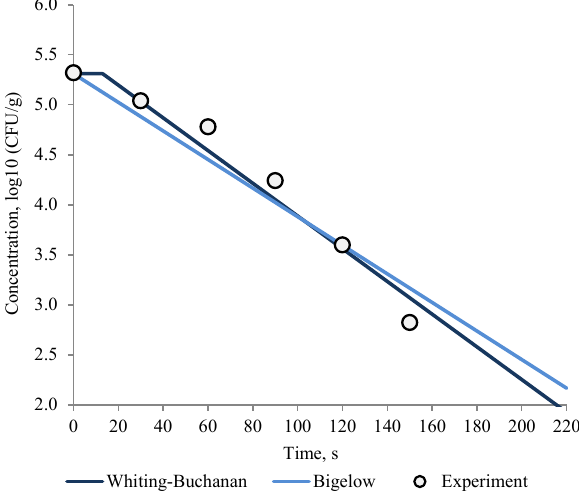
Figure 3 Approximation of experimental data of microbial death kinetics of A. acidoterrestris during heat treatment ( t = 105°C) by using linear models